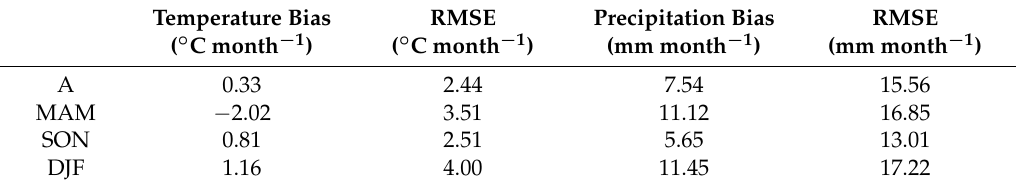
Table 1. Bias and RMSE over Xinjiang for annual and seasonal mean temperature and precipitation between WRF simulation and observation. A stands for annual, MAM for March-April-May, SON for September-October-November, and DJF for